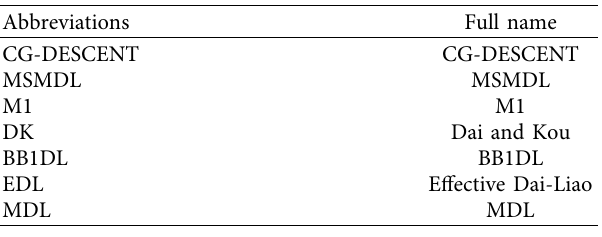
Figure 7: Numerical results generated by the MSMDL method for 􏽢 φ desired path, (c) tracking residual error on the x -axis, and (d) tracking residual error on the y -axis. Table 6: Abbreviations for the